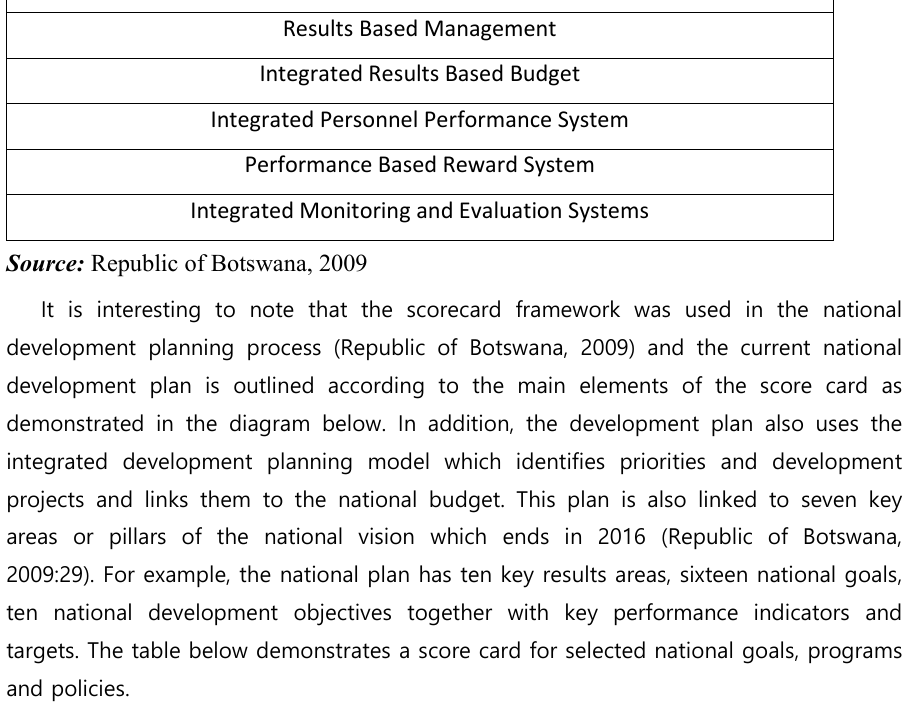
Table 5: Balanced Score and selected National Development Goals, Projects, Programs and Policies Balanced Score